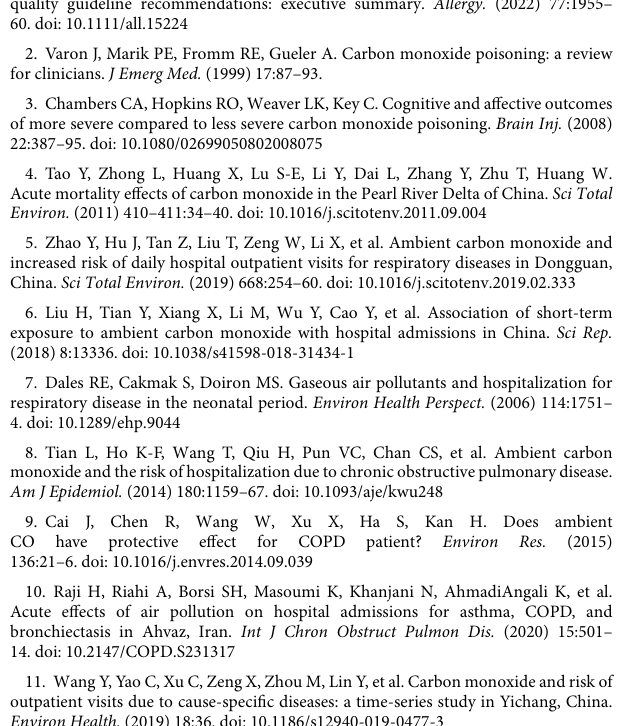
SUPPLEMENTARYFIGURES1 Exposure–response relationship between ambient carbon monoxide and hospitalization risks for respiratory diseases for dual and multiple pollution exposures. The vertical scale of the exposure–response curves can be interpreted as the log-relative change from the mean effect of carbon monoxide on the risk of hospitalization. The solid line represents the mean estimate, and the dashed lines represent the 95% confidence intervals. Exposure–response curves were performed at lag0–2 of ambient CO concentration for total and specific respiratory diseases. Models were adjusted for long-term and seasonal trends, temperature, relative humidity, public holiday, and DOW (day of the